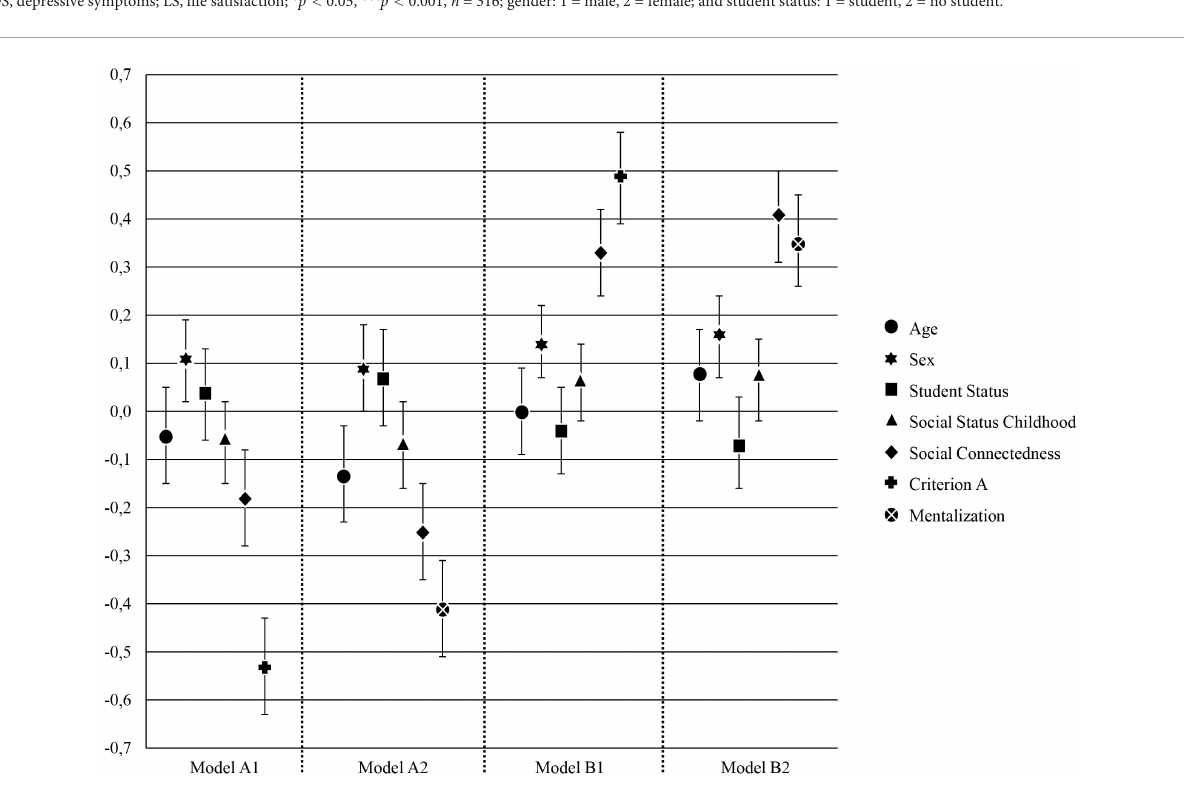
FIGURE1 Illustration of standardized regression coefficients β for models A1 and A2 (depressive symptoms) and B1 and B2 (life satisfaction; n = 316). Error bars representing 95% bootstrapped confidence